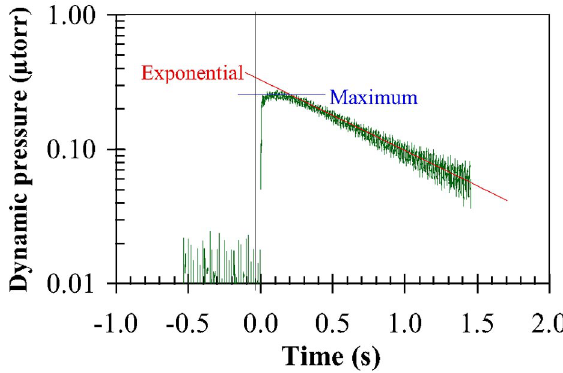
FIG. 13. (Color) The pressure rise measured by an ion gauge. The horizontal blue line indicates the peak excursion of the ion gauge current. The red line indicates a fit to the exponential decay of the ion gauge current, which we evaluate at t (cid:4) 0